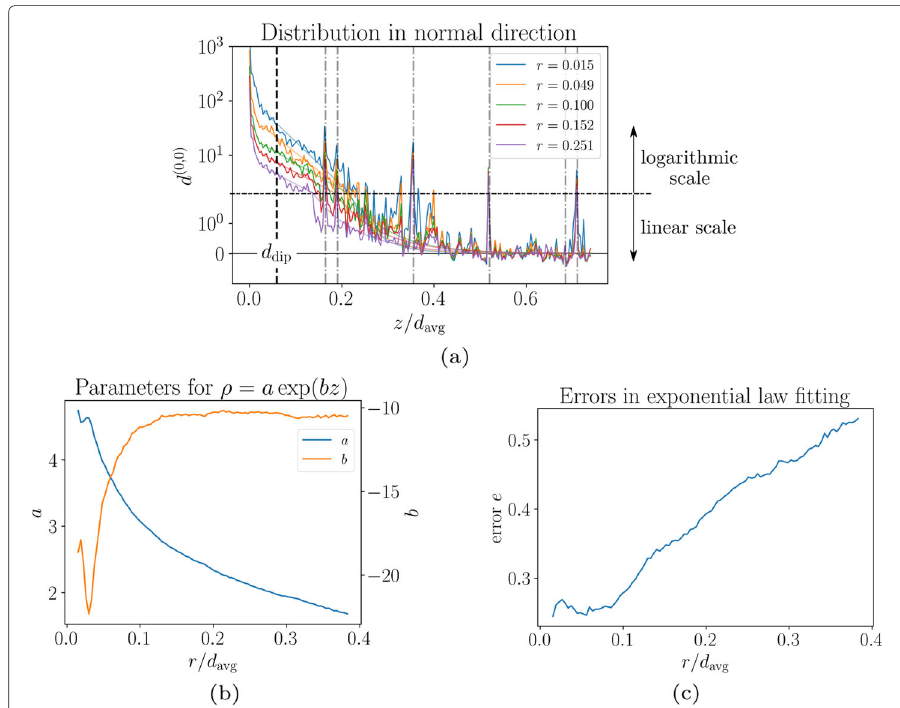
Fig. 18 Analysis of the z -dependency of the correlations based on the data averaged over the angular domain. z -dependent correlation for various values of r ( a ). The black dashed line indicates the average dipole height, cf. Eq. (109). The gray dash-dotted lines indicate peaks due to re-entrance of in-plane self-correlation through the periodic domain. The ordinate uses a logarithmic scale which transitions into a linear scale for values smaller than 2. Coefficients of the exponential fitting dependent on the radial in-plane distance r ( b ). Error e in the exponential fitting according to Eq. (111) ( c